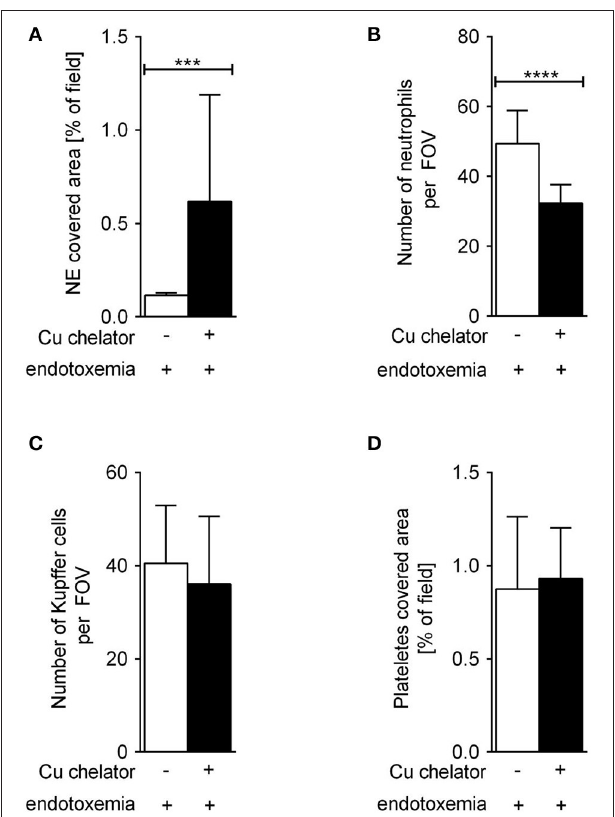
FIGURE 6 | The impact of subchronic copper deficiency on NET formation (A) , neutrophil numbers (B) , Kupffer cell counts (C) , and platelet covered area (D) in C57Bl/6J mice. Copper chelator (Cu chelator) was administered for 8 days and then LPS-systemic inflammation was induced. NET covered area and cell counts were performed 24h later. Asterisks indicate significant differences using unpaired two-tailed Student’s t test (*** P ≤ 0.001, **** P ≤ 0.0001).